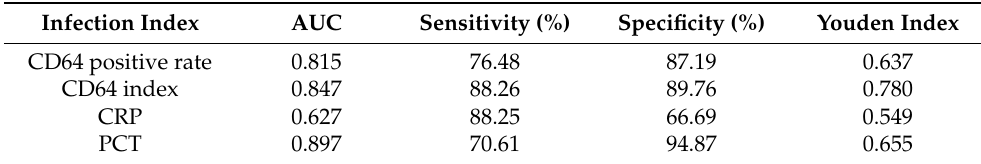
Figure 2. ROC curves of infection indicators for the diagnosis of acute pancreatitis and sepsis. Table 5. Diagnostic efficacy of infection indicators for acute pancreatitis complicated with